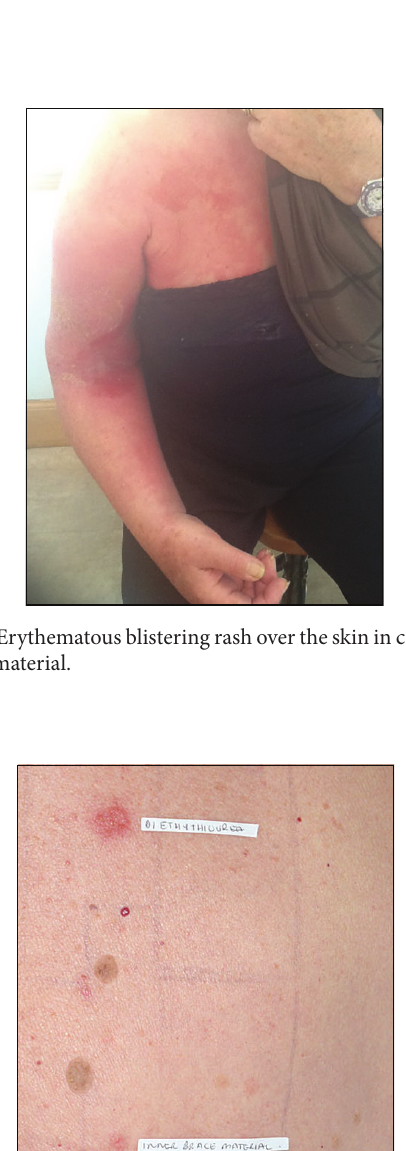
Figure 1: Itchy reaction to a wrist splint used for psoriatic arthropa- thy.